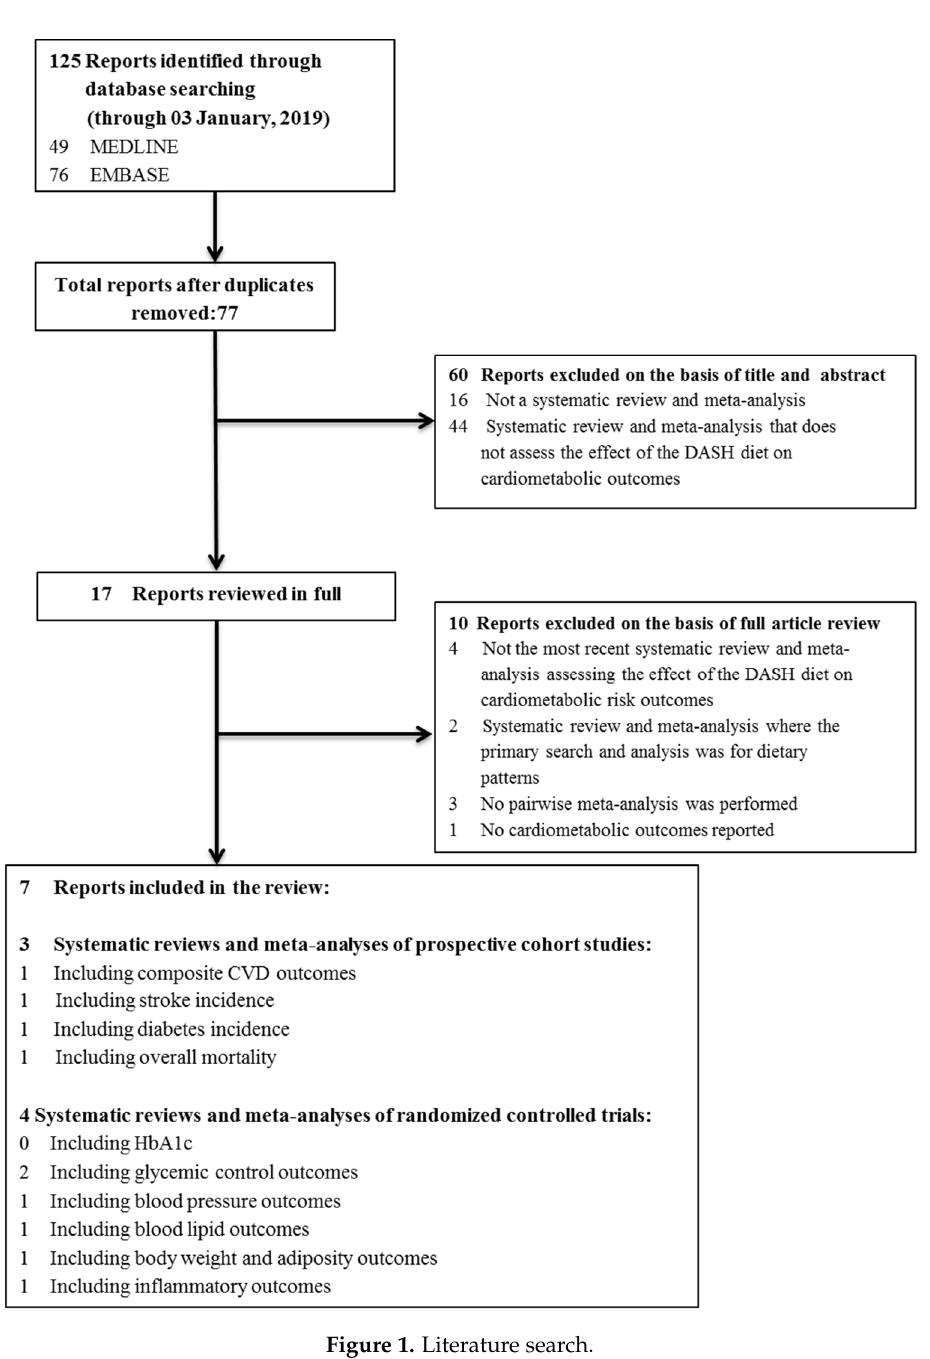
Figure 1. Literature search.